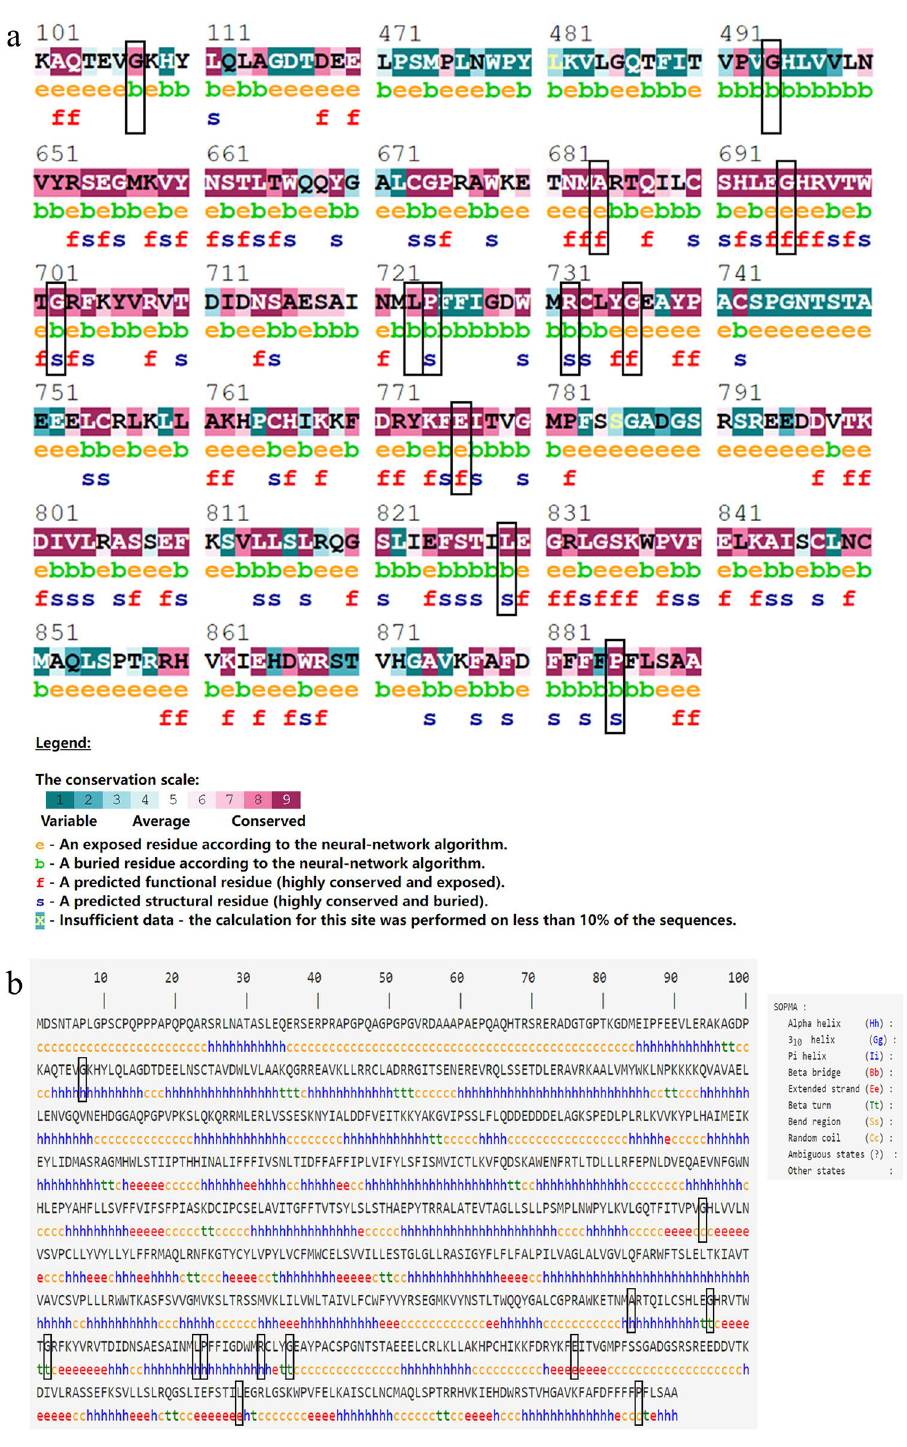
Figure 3. Combined figures. ( a ) The prediction results of ConSurf software about the evolutionary conservation of WFS1. The mutant amino acid sites are highlighted by black boxes. The color-coding bar represents the conservation score. ( b ) The secondary structure of wolframin protein according to SOPMA analysis. The high-risk nsSNPs are highlighted by black